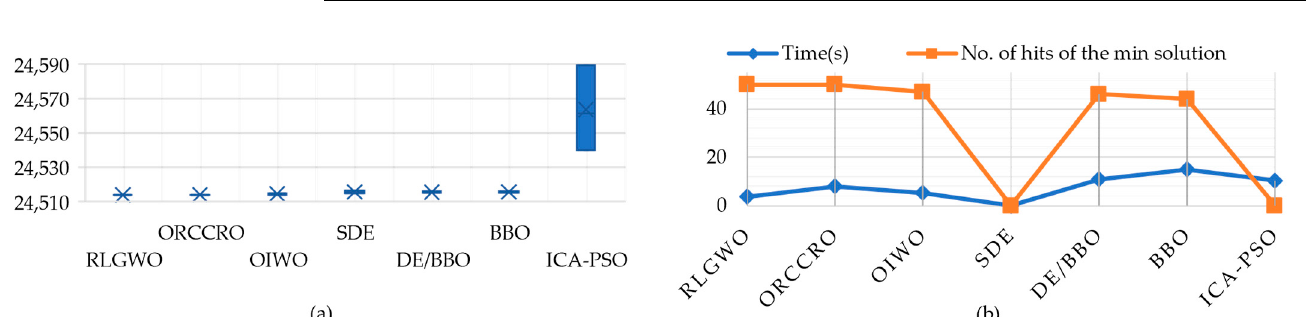
Figure 5. Results for different methods for the 13 ‐ unit system (50 trials): ( a ) boxplot of the final gen ‐ eration cost; ( b ) time and number of hits of the minimum solution.